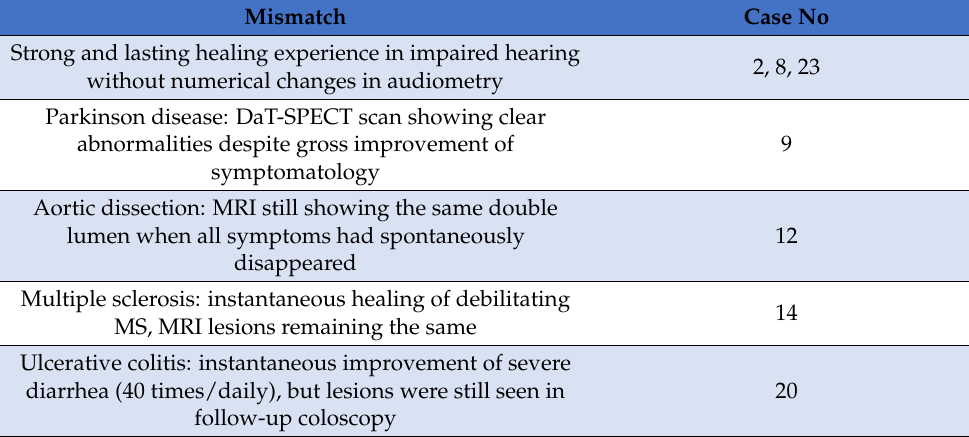
Table 8. Mismatches between subjective and objective data were outspoken in seven cases.